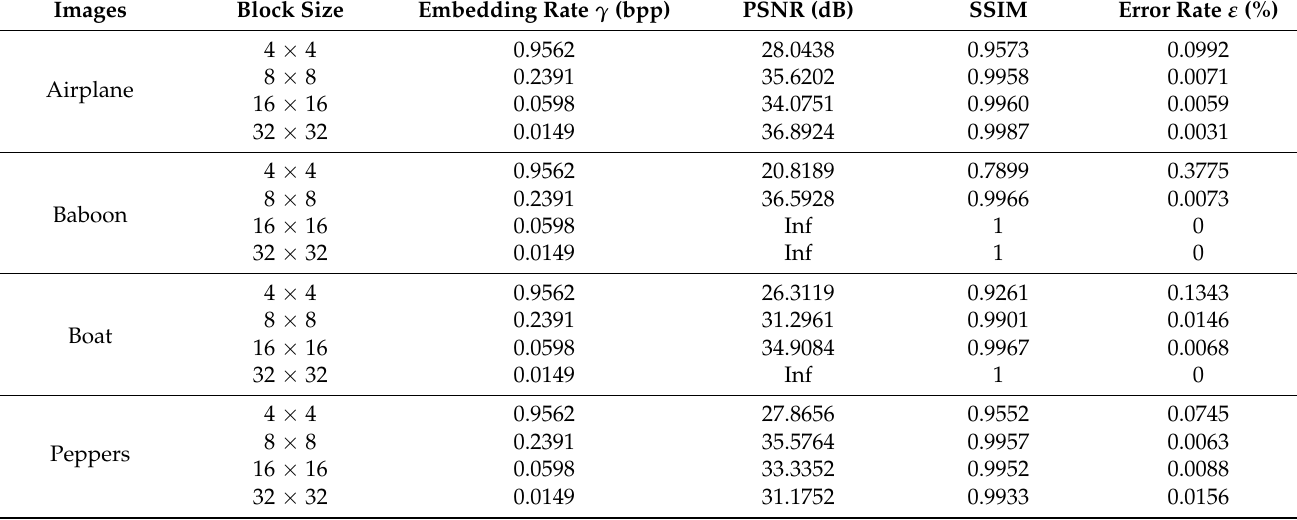
Table 3. Performances when number of sub-blocks = 8 and codebook size =